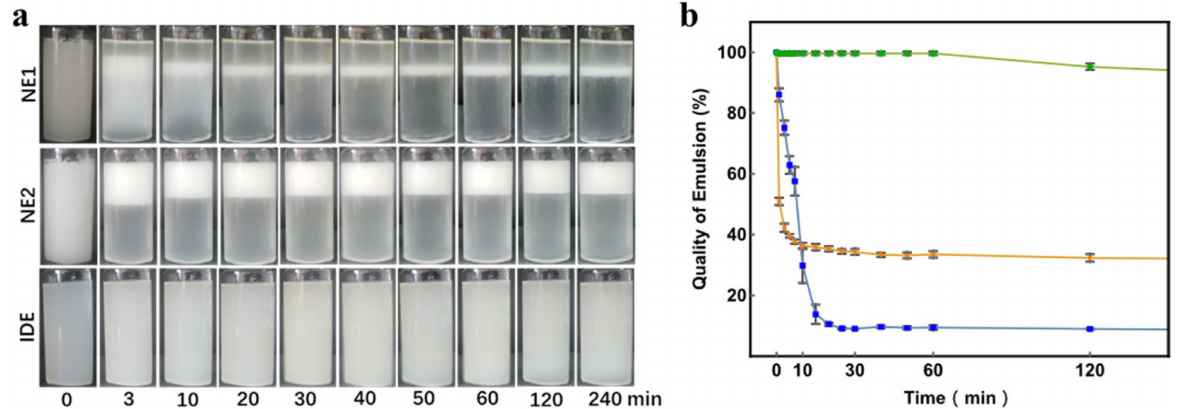
Figure 2. ( a ) Phase separation of NE1, NE2, and IDE at different time points; ( b ) corresponding emulsion quality of NE1, NE2, and IDE over time ( n =